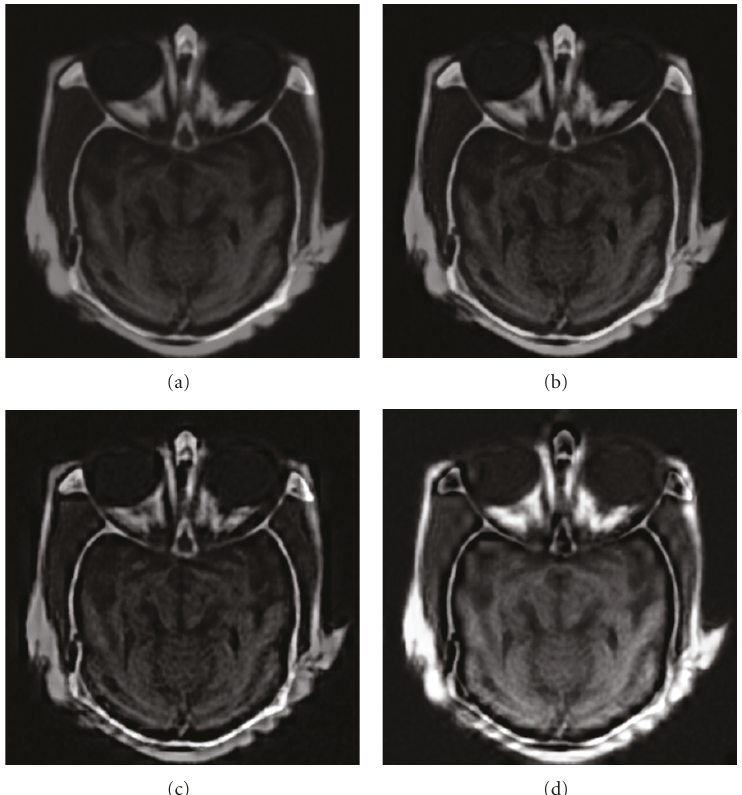
Figure 7: Fusion results of the CT and MR images with di ff erent methods. (a) Fused image by pixel averaging; (b) fused image by gradient pyramid; (c) fused image by DWT; (d) fused image by the proposed